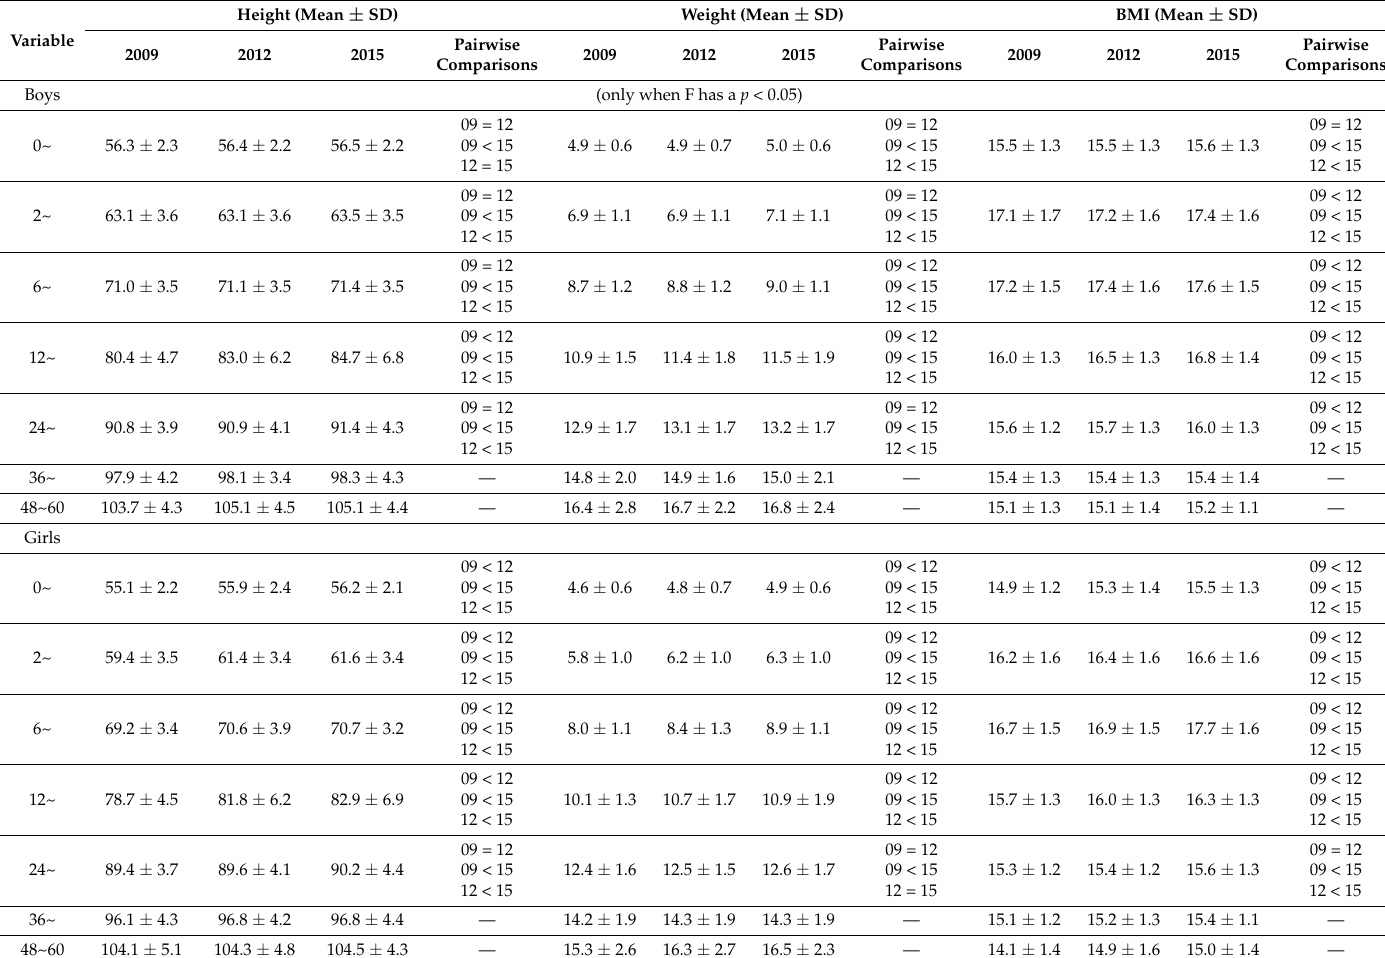
Table 3. Means and standard deviations for height, weight, and BMI in boys and girls by months of age and year of evaluation (ANCOVA results).